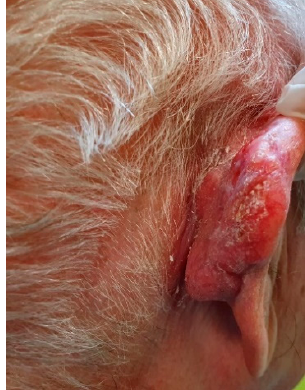
Figure 2. Retroauricular basal cell carcinoma .